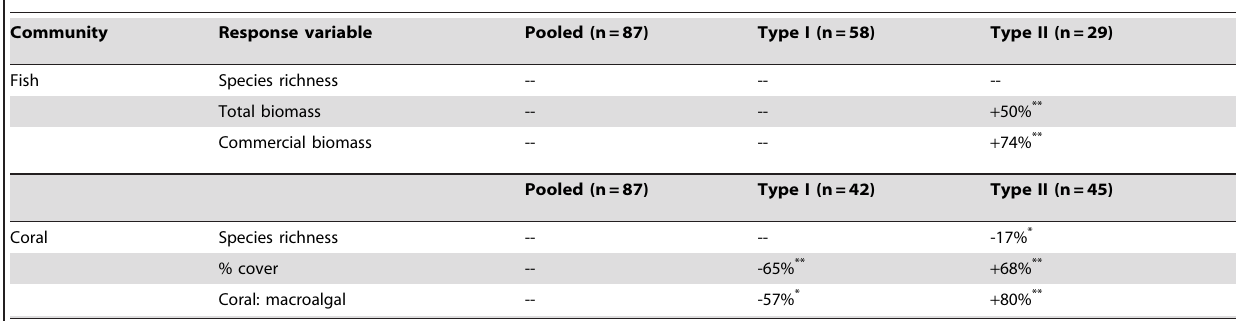
Table 3. Reserve effects using different site classification scenarios.